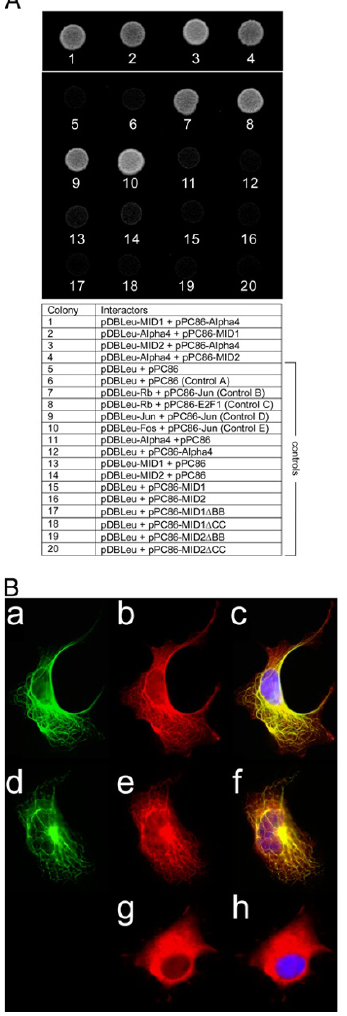
Figure 1 Alpha 4 interacts with MID1 and MID2. (A) Yeast two-hybrid analysis of the interaction between MID1 and Alpha 4 as well as MID2 and Alpha 4. Yeast agar plate (leu - trp - his - , 75 mM 3-AT) showing growth for MID1/Alpha 4 and MID2/Alpha 4 interactions as well as positive control two-hybrid combina- tions and no growth for negative controls. (B) Detection of full-length myc tagged-Alpha 4 when co-expressed with GFP- MID1 and GFP-MID2 fusion proteins in transiently trans- fected Cos1 cells. (a) GFP-MID1 fluorescence (green), (b) anti-myc antibody detecting myc-Alpha 4 localisation (red), (c) overlay of (a), (b) showing co-localisation of the myc- Alpha 4 fusion protein and GFP-MID1, with DAPI stain for DNA (blue). (d) GFP-MID2 fluorescence (green), (e) myc- Alpha 4 localisation (using same detection as b) (red), (f) overlay of (d), (e) with DAPI (blue) showing co-localisation of the myc-Alpha 4 fusion protein and GFP-MID2. (g) Detection of transiently expressed myc-Alpha 4 fusion protein in Cos1 cells, (h) overlay of (g) and DAPI stain showing cytoplasmic distribution of myc-Alpha 4 fusion